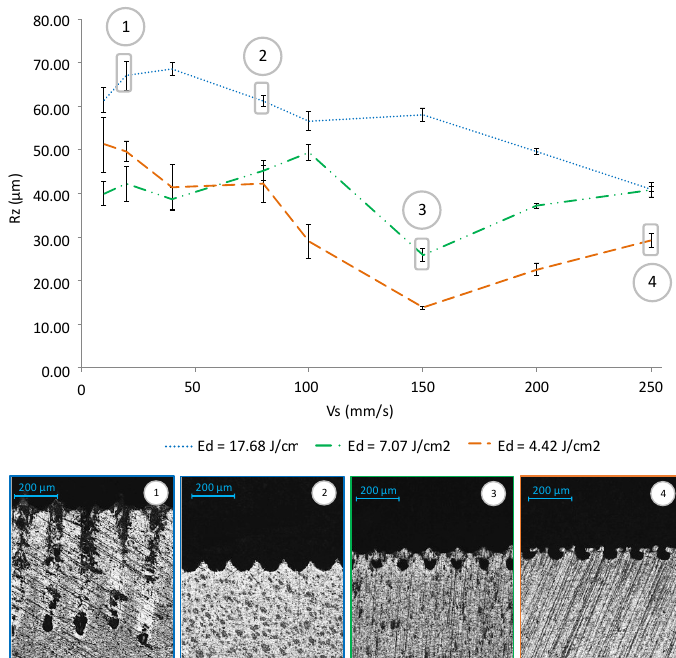
Figure 1. Roughness R z behavior as a function of V s .